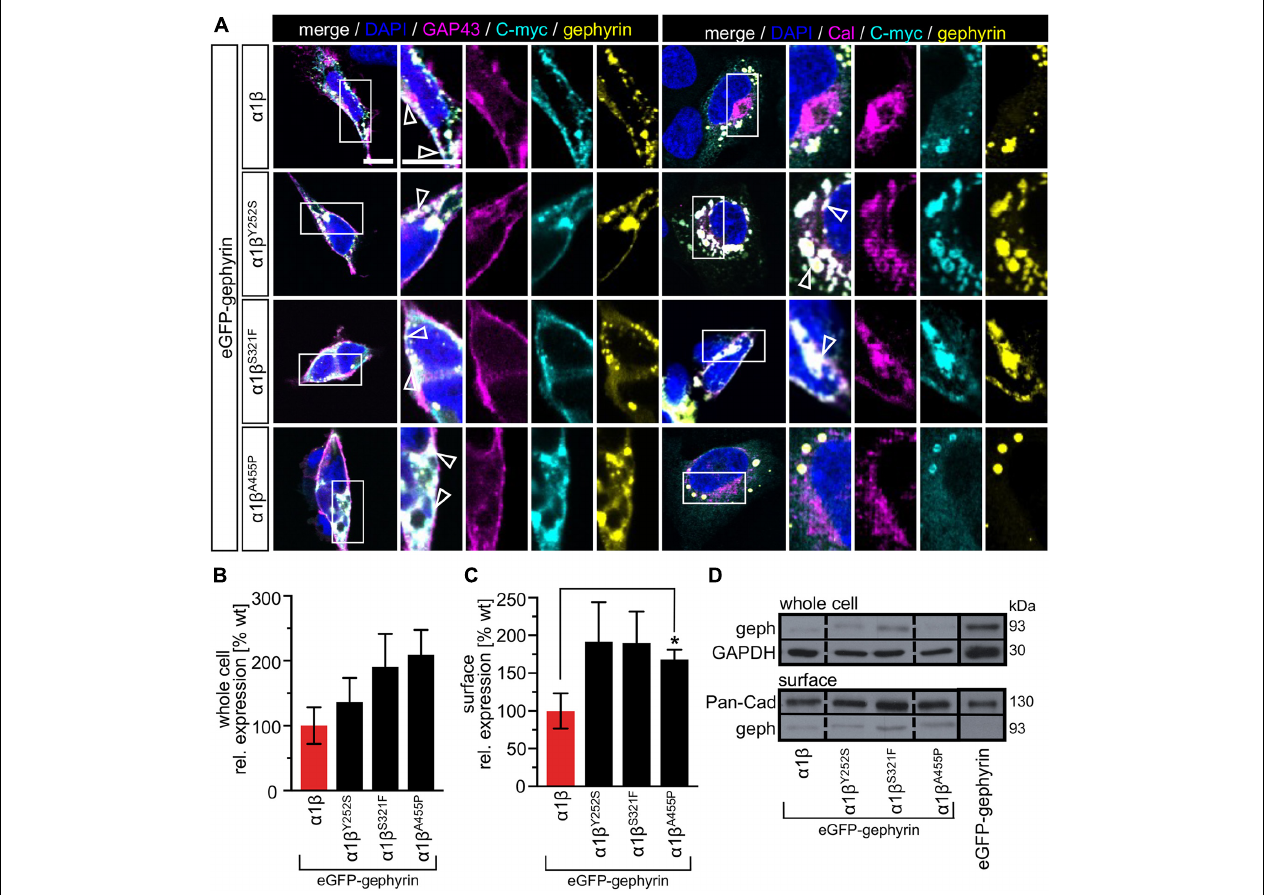
FIGURE 5 | Membrane expression of GlyR β variants is altered in the presence of gephyrin. (A) HEK-293 transfected with GlyR α 1, eGFP-gephyrin and β WT or β x variants (Y252S, S321F or A455P). Cellular compartment markers (GAP-43: cell membrane, calreticulin (Cal): endoplasmic reticulum) are always co-transfected (magenta). GlyR β WT or variants are stained with an anti-myc antibody (cyan), eGFP-gephyrin is shown in yellow. White boxes mark the areas shown in the enlarged images. Arrow heads point to co-localization or accumulation of eGFP-gephyrin and β WT or β variants. Scale bars refer to 10 µ m. (B,C) Quantitative analysis of eGFP-gephyrin in whole cell fraction (B) and surface (C) fractions ( n = 4, four independent experiments) of co-expressed GlyR α 1 together with β WT (red bar) or GlyR β variants (black bars) and eGFP-gephyrin. (D) Representative Western blots of whole cell and surface fractions from transfected HEK-293 cells. eGFP-gephyrin (geph) is detected at the appropriate molecular weight of 93 kDa, Pan-cadherin (Pan-Cad) served as loading control for surface fraction (130 kDa) and GAPDH served as loading control for whole cell fraction (30 kDa). Level of significance * p <